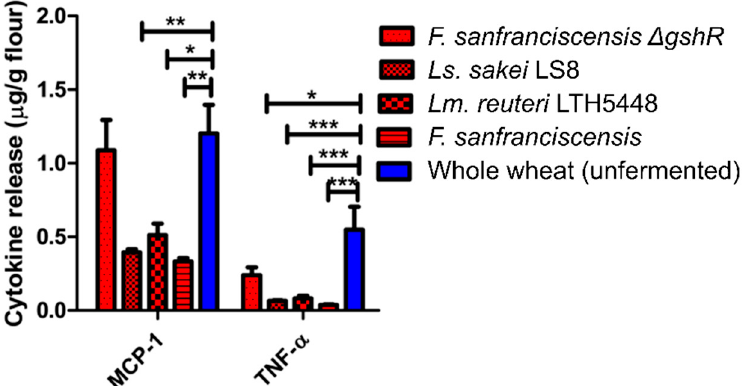
Figure 7. ATI bioactivity of whole wheat fermented by four Lactobacillus strains ATI were extracted from freeze-dried doughs, and extracts added to toll-like receptor 4 (TLR4) expressing THP-1 human monocytic cells. The release of monocyte chemoattractant protein-1 (MCP-1) and tumour necrosis factor alpha (TNF- α ) into the culture medium was quantified by enzyme-linked immunosorbent assay (ELISA). (* p < 0.05; ** p < 0.01; *** p < 0.001).